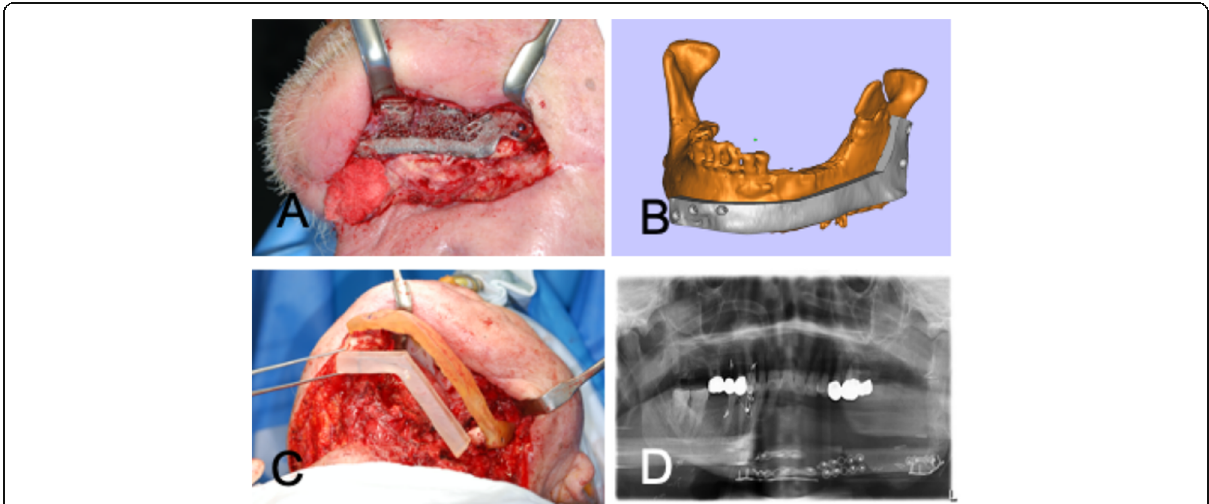
Fig. 2 Reconstruction of mandibular composite tissue after removal of the failed graft. a Exposure of the 3D printed titanium block. b Virtual simulation surgery and design of a 3D surgical template. c Intraoperative application of the 3D-printed surgical template. d Restored mandibular occlusion after reconstructive surgery